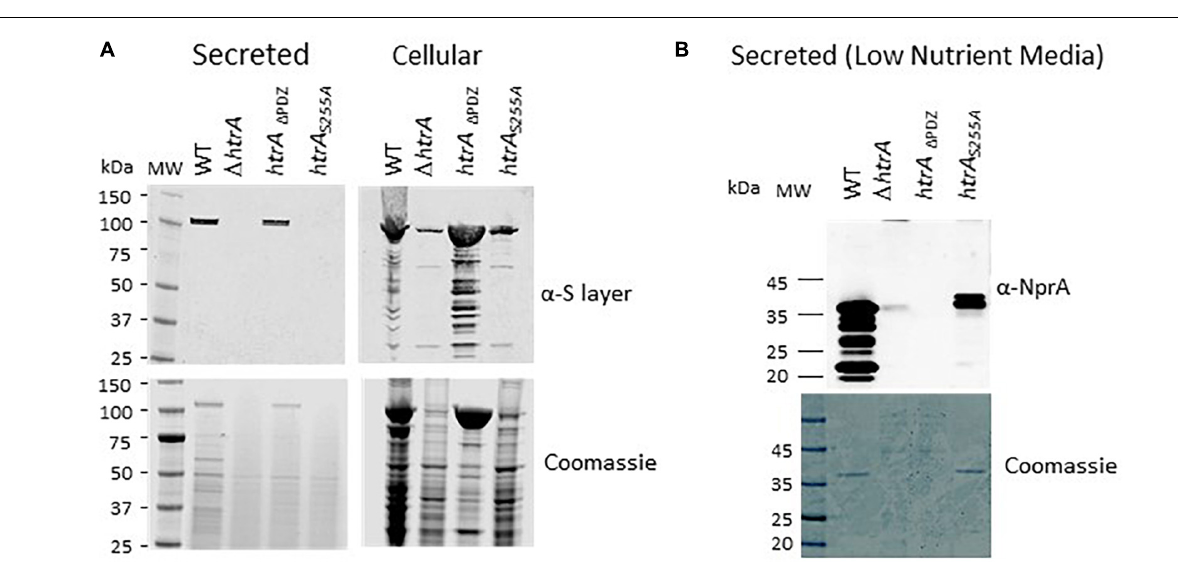
Frontiers in Microbiology |